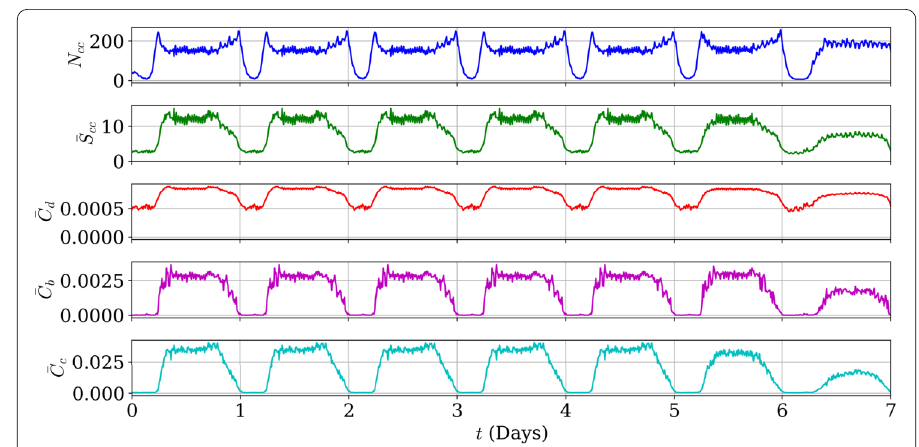
Figure 7 Connectivity and centrality analysis on temporal Great Britain rail